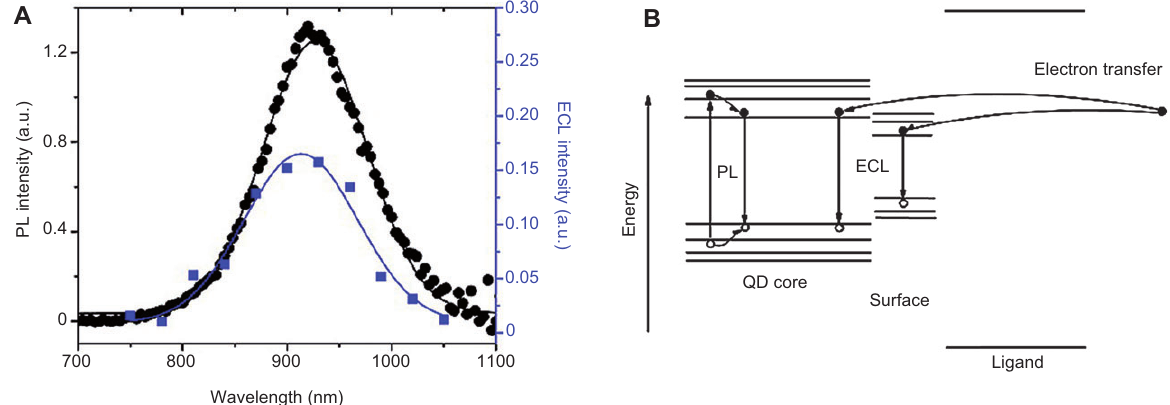
Figure 2 (A) PL (dot) and ECL (square) spectrum of PbS QDs with oleic acid and TOP capping in CH Gaussian fits to each data set. (B) Schematic mechanism of PL and ECL. (Reproduced with permission from ACS